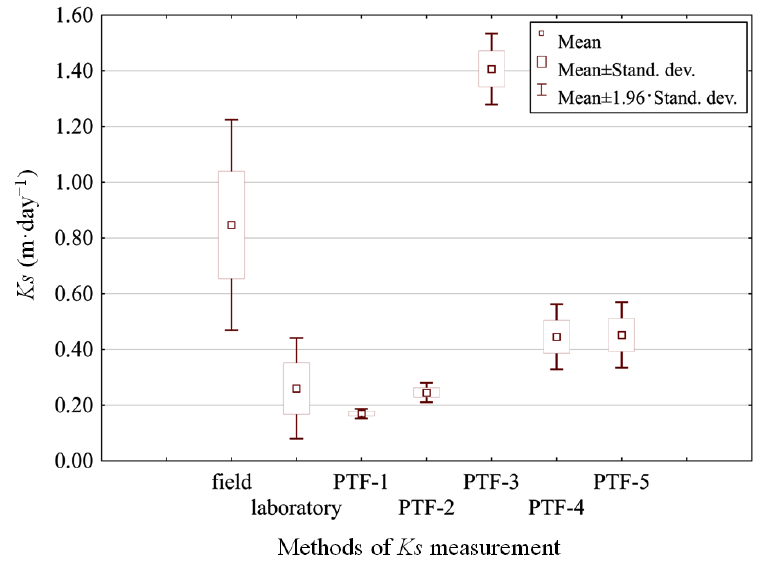
Figure 5. Box plots showing the performance of Ks to different measurement methods.